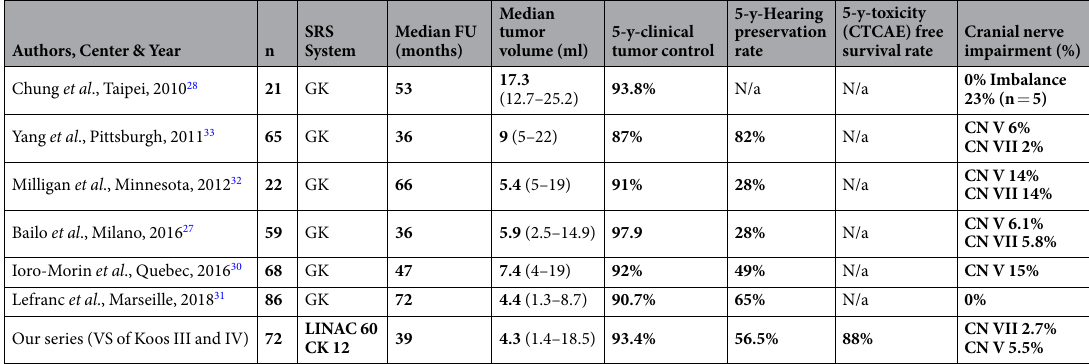
Table 4. Characteristics of preexisting retrospective single-center series dealing with the radiosurgical treatment of large